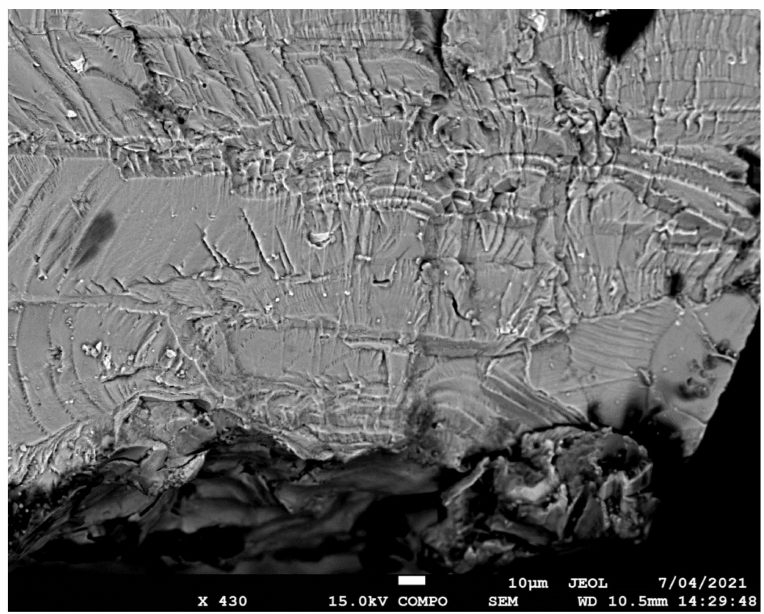
Figure 7. SEM of the lead crack (Crack 2) in specimen 3. The measured and computed crack growth histories are shown in Figures 8–10, where we see excellent agreement between the computed and measured crack growth histories. Table 3 reveals that the value of ∆ K thr associated with these nine cracks falls within the range 0.0 to 0.3 that is commonly seen for small cracks in conventionally man- ufactured aluminium alloys [1,21,25–27,33,34,36,38,39]. In contrast, the ∆ K thr range seen in [37] for the growth of long cracks in AA7075-T7351 aluminium alloy specimens tested un- der a FALSTAFF flight load spectrum was between (approximately) 1.1 and 1.79 MPa This difference is typical of that seen by long and small cracks [21,25].